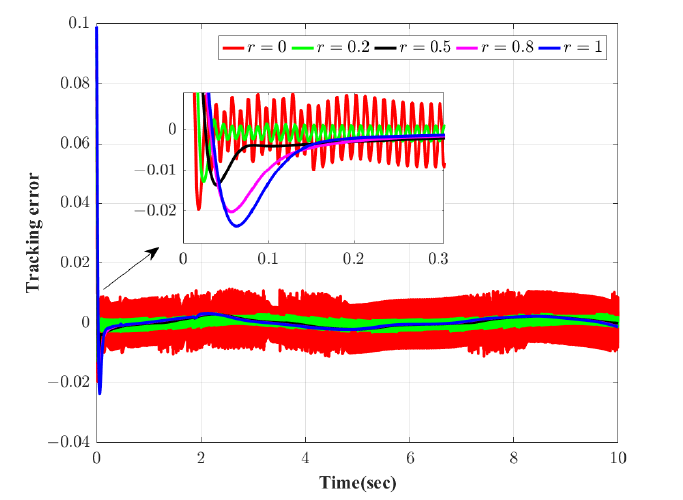
Figure 5. Tracking errors.